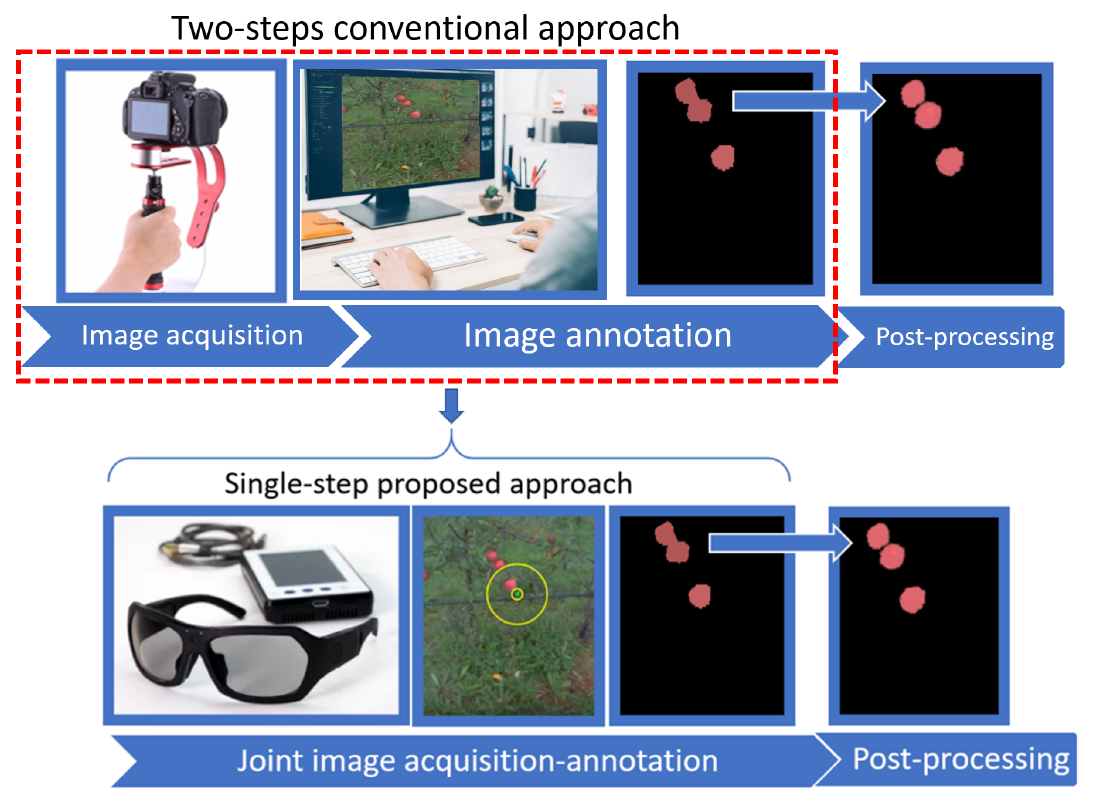
Figure 1. Visual abstract of the article. The red dotted-line encapsulates the conventional two steps of the acquisition and annotation process. We jointly perform image acquisition and image annotation by the use of a head-mounted egocentric device, which simultaneously captures images and the gaze of the person who wears the device and reaps benefits from both factors to annotate images automatically. It is to be noted that the post-processing step to separate touching annotated objects is not included here. It remains a step necessary in the conventional two-step approach and our proposed single-step